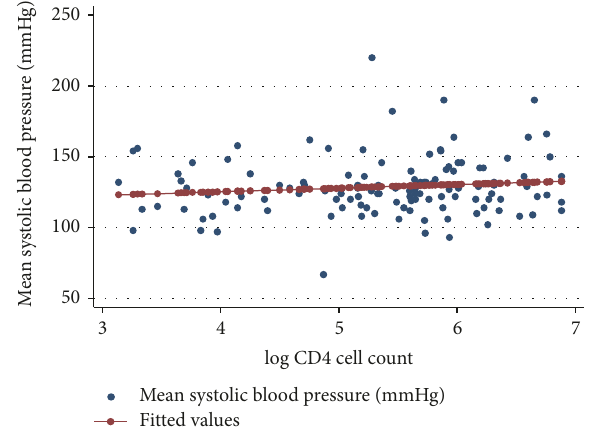
Figure2:ScatterplotformeandiastolicbloodpressureandlogCD4 cell count. The red line represents the prediction line of the regression